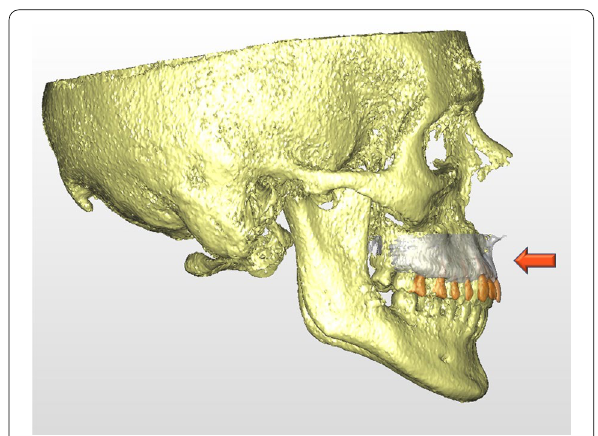
Fig. 10 Surgery-first tends to underreach the maxillary advancement: maxilla is retruded by around 1 mm when compared to VSP